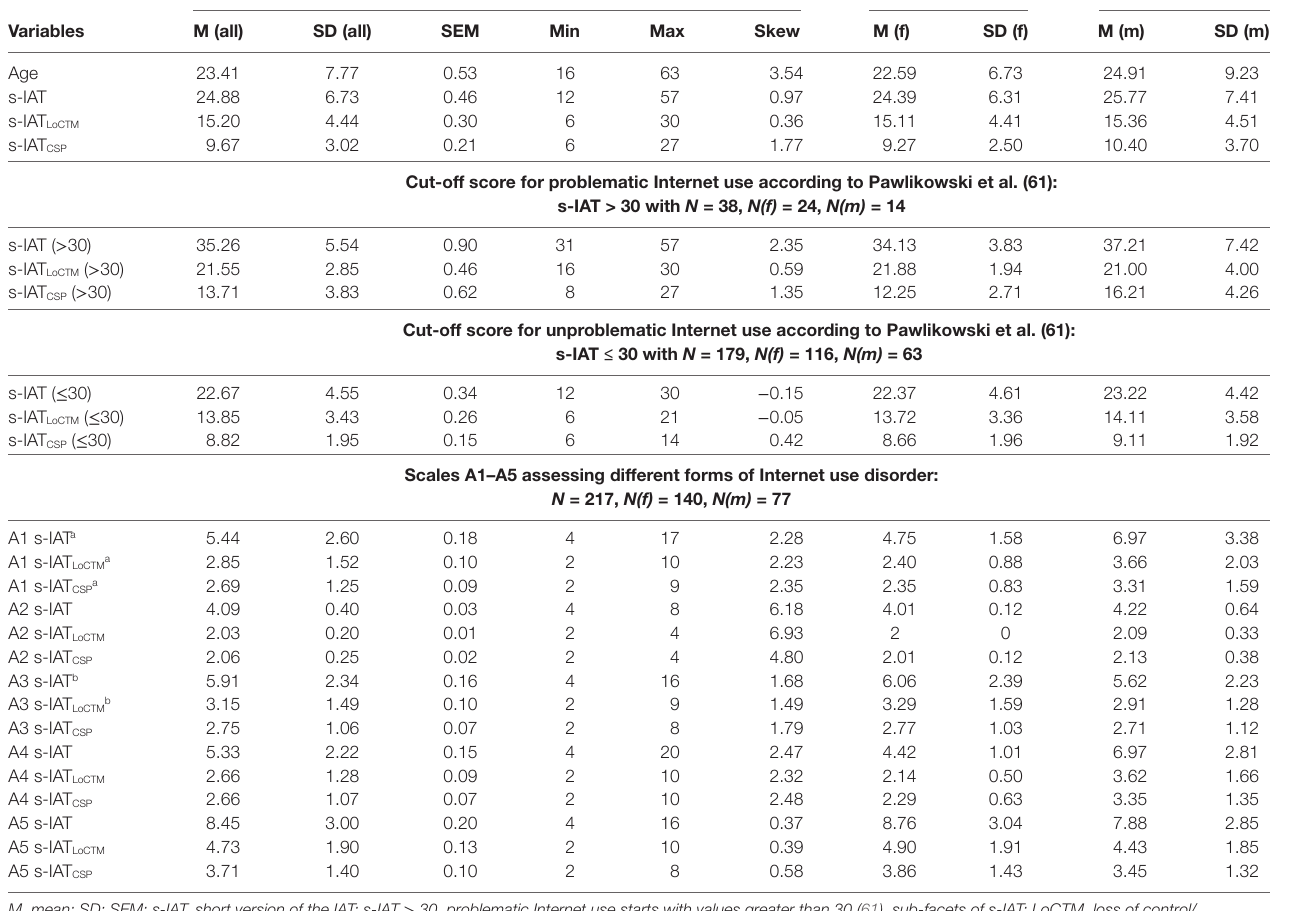
entire sample N = 217 Females N(f) = 140 Males N(m) = 77